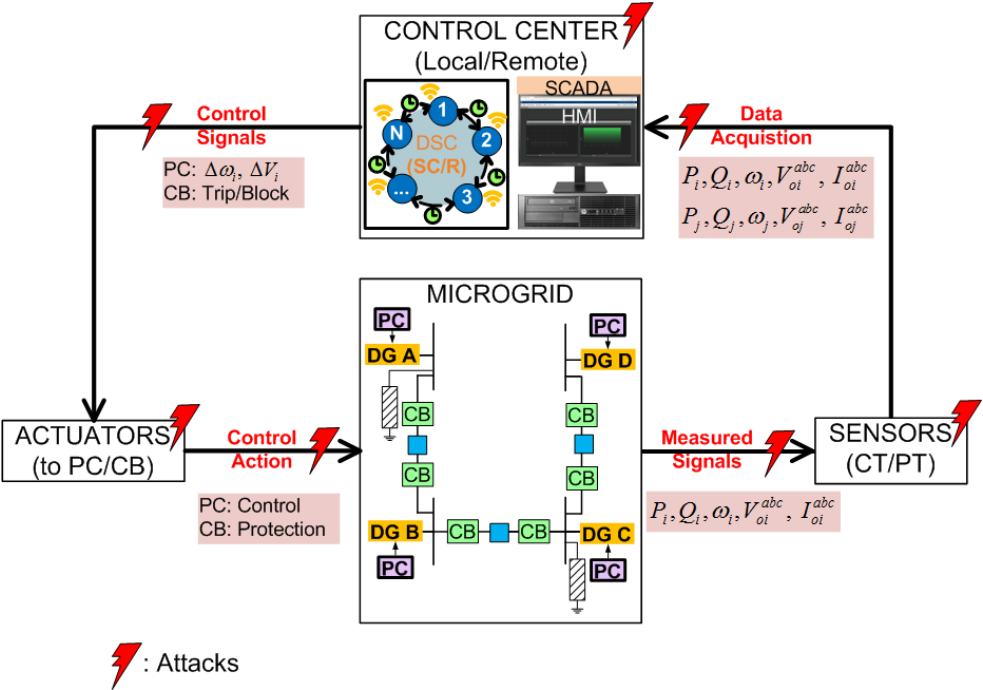
Figure 8. Attack surface view on the